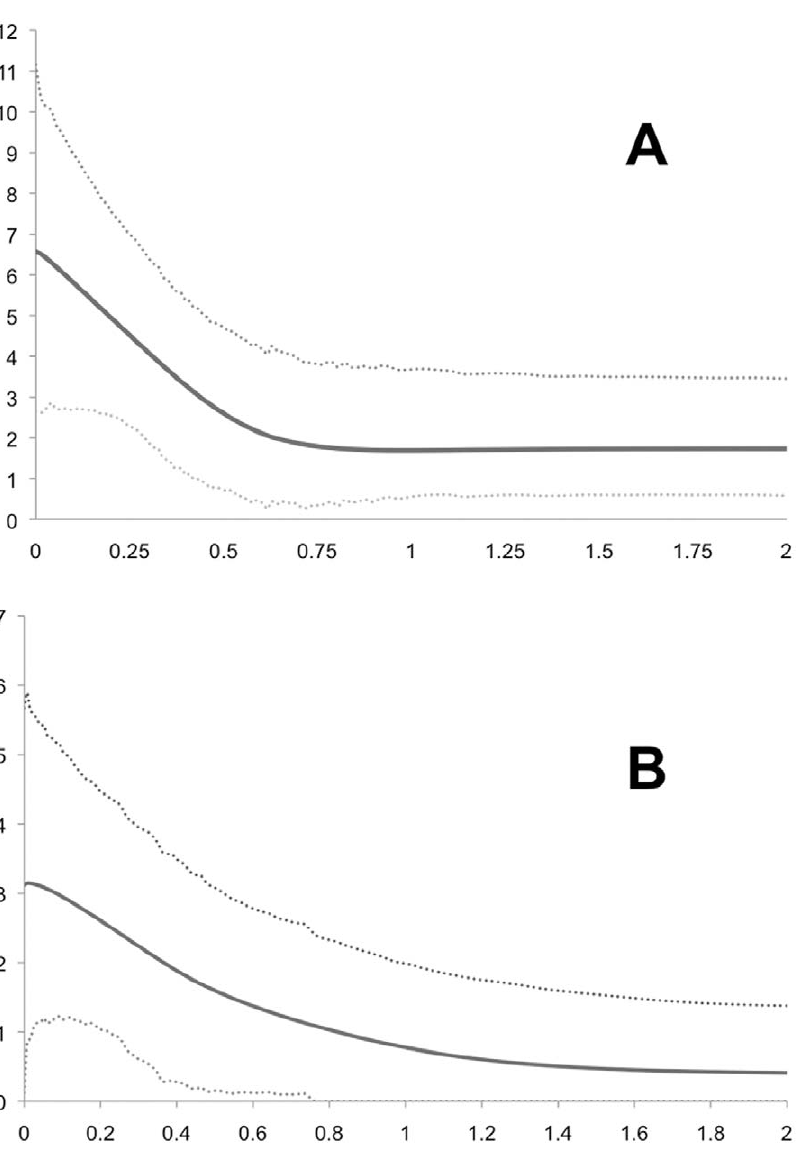
Figure 8. Extended Bayesian Skyline Plots (EBSPs). EBSPs represent population size changes over time in two of the mtDNA clades, inferred by mtDNA and multiple nuclear loci. Y-axes are effective population size divided by generation time. X-axes are in millions of years. A: Suwannee. B: Everglades.